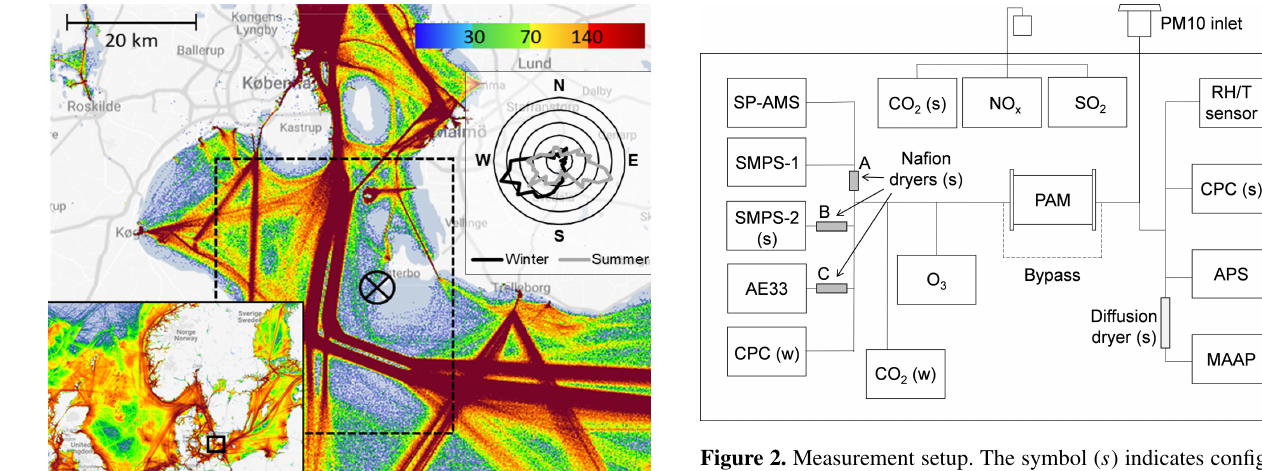
Figure 2. Measurement setup. The symbol ( s ) indicates configura- tion used only during the summer and ( w ) only during the winter. The dashed line shows the bypass flow excluding the PAM oxida- tion flow reactor from the sampling line. For the membrane (Nafion) dryers, the letters correspond to the size-dependent particle penetra- tion for each drier shown in Fig.